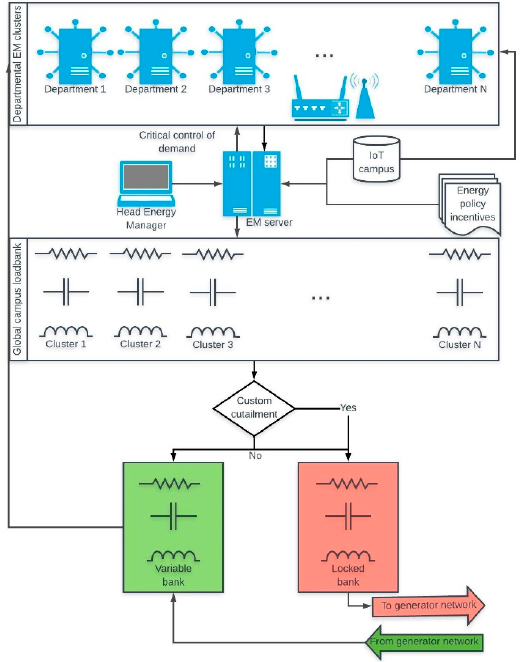
Figure 2. Optimization scheme to determine the variable / locked load banks to be fed to the diesel generator optimization scheme. This scheme depends on low-level departmental control and energy management policies.